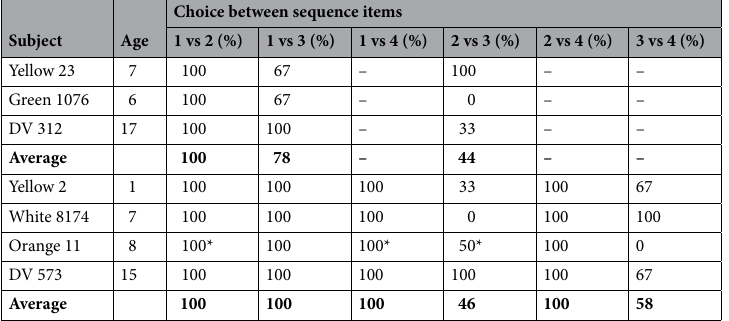
in contrast to all four subjects in the young group that passed this stage. Finally, none of the subjects that entered TS4 were able to pass the criterion within the number of training sessions they received, leading to an observable